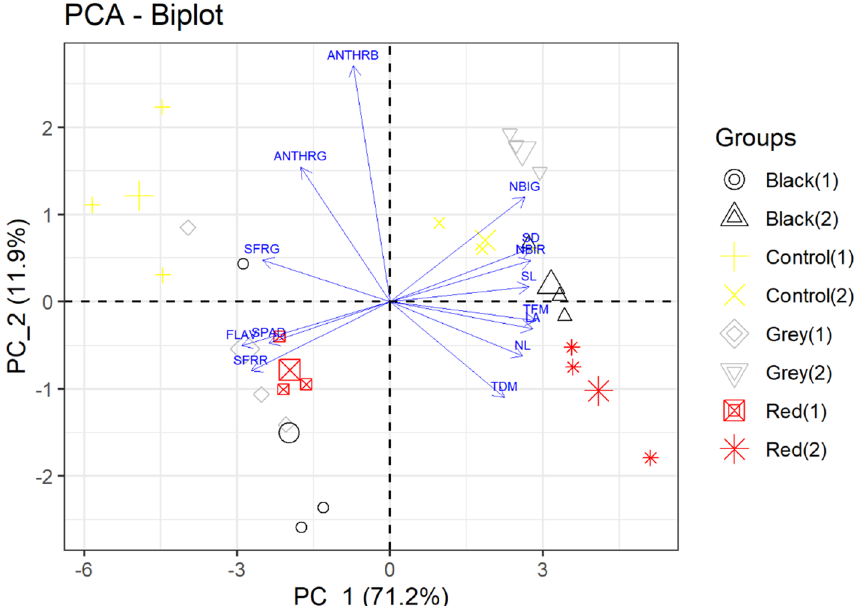
Figure 3. Principal component analysis of variables associated with lettuce growth and physiology cultivated two planting seasons and in different photo-selective screens (black, control (full sun), silver and red). (1) Spring; (2) Autumn. TFM total fresh matter, TDM total dry matter, NL number of leaves, SD stem diameter, SL stem length, LA leaf area, SPAD chlorophyll index; nitrogen balance indexes (NBIG and NBIR), chlorophyll (SFRG and SFRR), flavonoids (FLAV) and anthocyanins (ANTHRG and